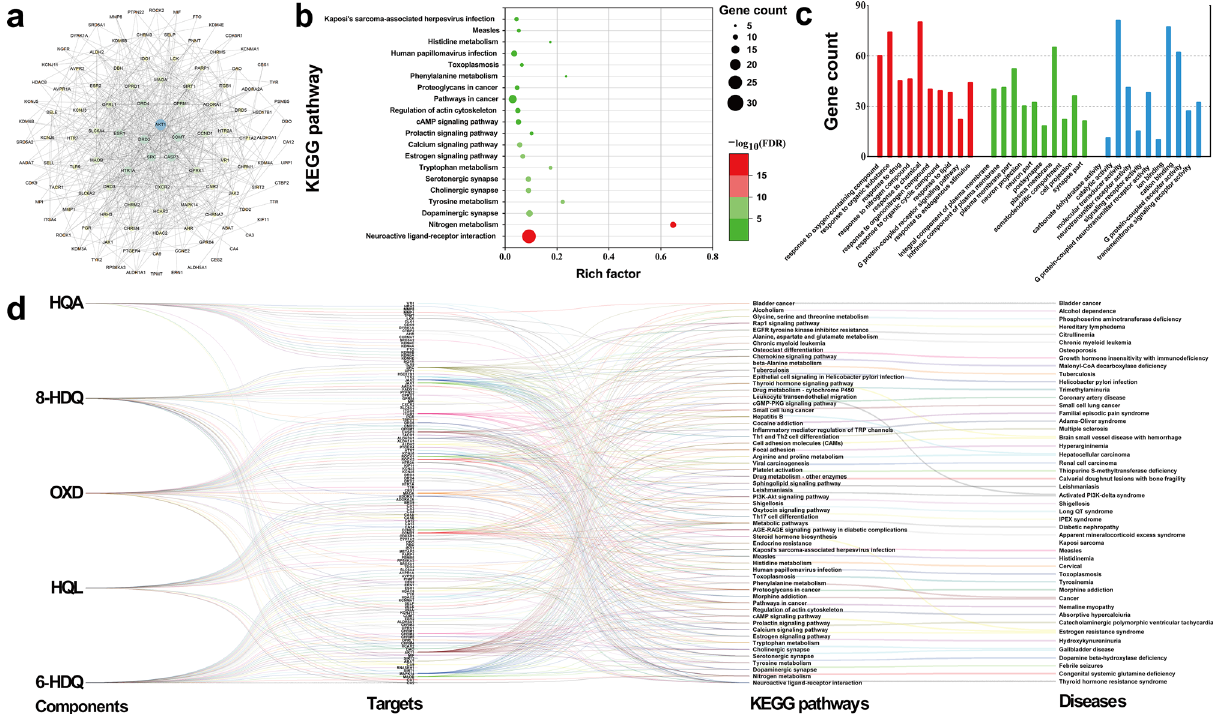
Figure 2. The results of network pharmacology analysis of NCMs. ( a ) Protein–protein interaction (PPI) network for the predicted targets of NCMs. ( b ) Top 20 of Kyoto Encyclopedia of Genes and Genomes (KEGG) pathway enrichment terms for NCMs. ( c ) Gene Ontology (GO) enrichment terms of NCMs involving Biological Process (BP), Cellular Component (CC), and Molecular Function (MF). ( d ) Compounds-targets-pathways- diseases network represents the potential relationships among NCMs, targets, action mechanisms, and diseases.